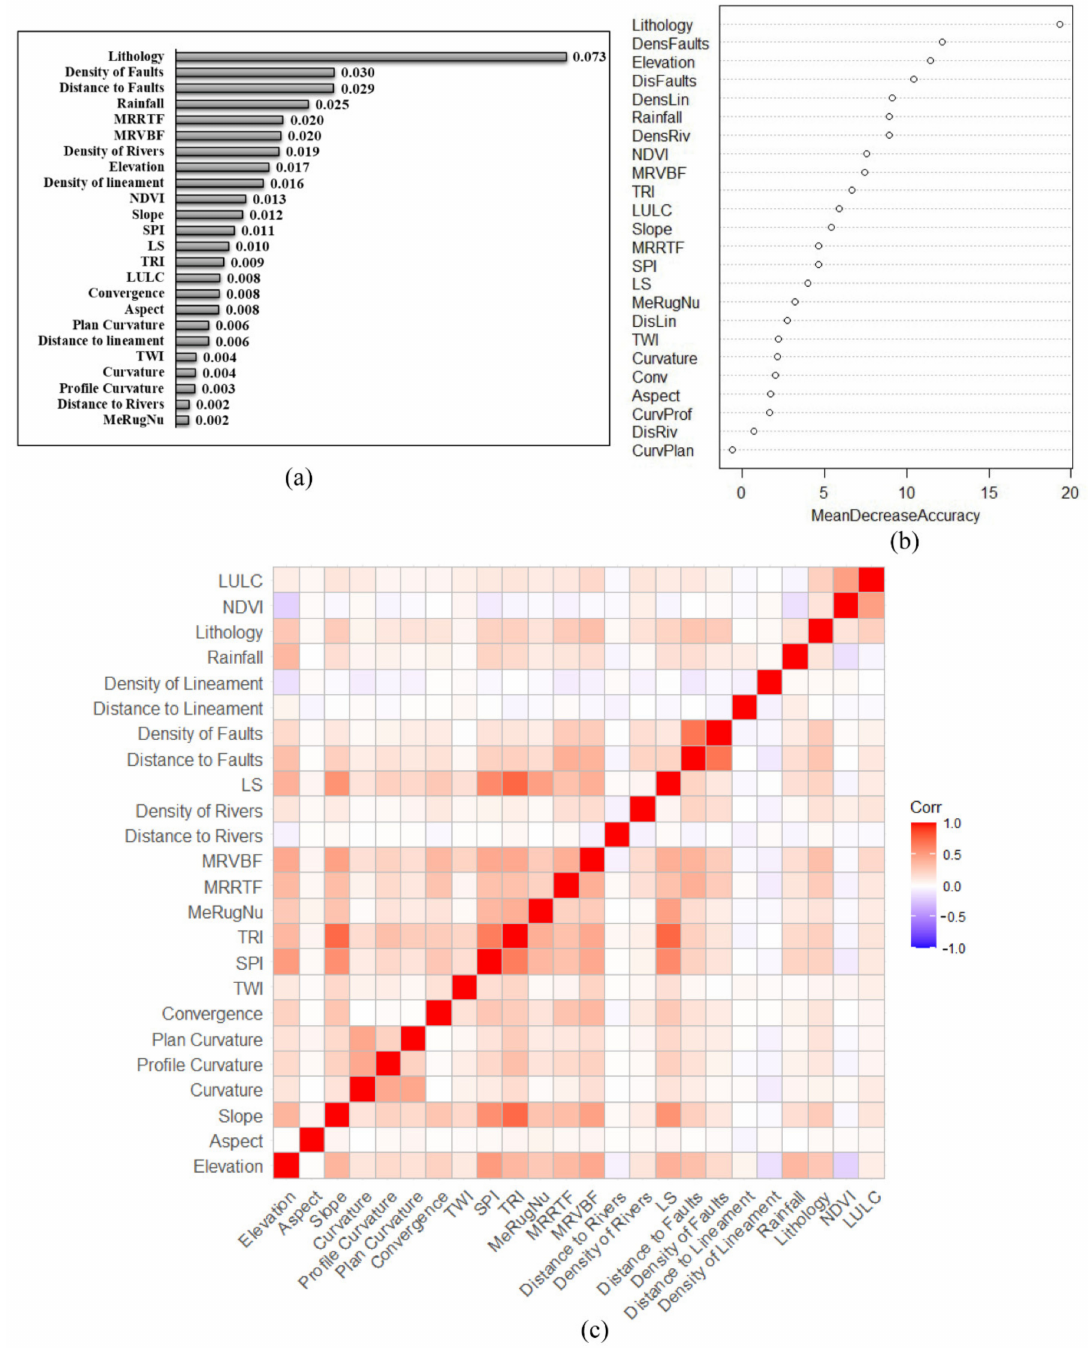
Figure 6. Predictive capabilities using information gain method: ( a ) importance of GIFs derived from Random Forest model; and ( b ) correlation matrix of the twenty-four GIFs ( c